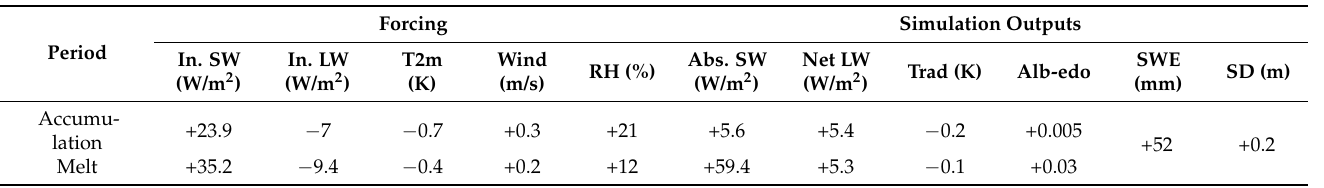
Table 4. Snow and Liquid Fractions of the Total Precipitation during the accumulation period at Peak SWE for water years 2014–2019. Table 3. Mean Bias in NLDAS-2 and NLDAS2-Noah-MP compared to the Station and Station-Noah- MP (WY 2014 – 2019). Period